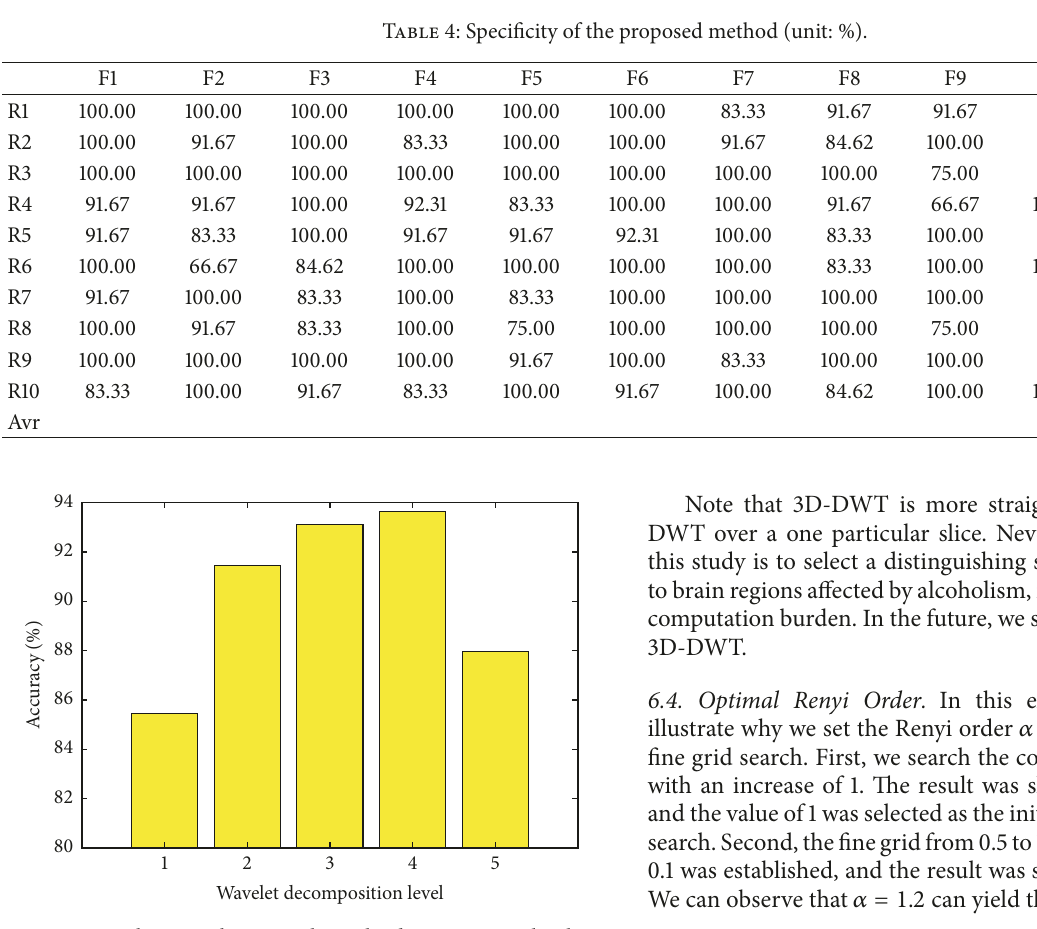
corresponding accuracy varied as shown in Figure 8. Here, the accuracy is 85.45%, 91.45%, 93.11%, 93.66%, and 87.96% when decomposition level is 1, 2, 3, 4, and 5,